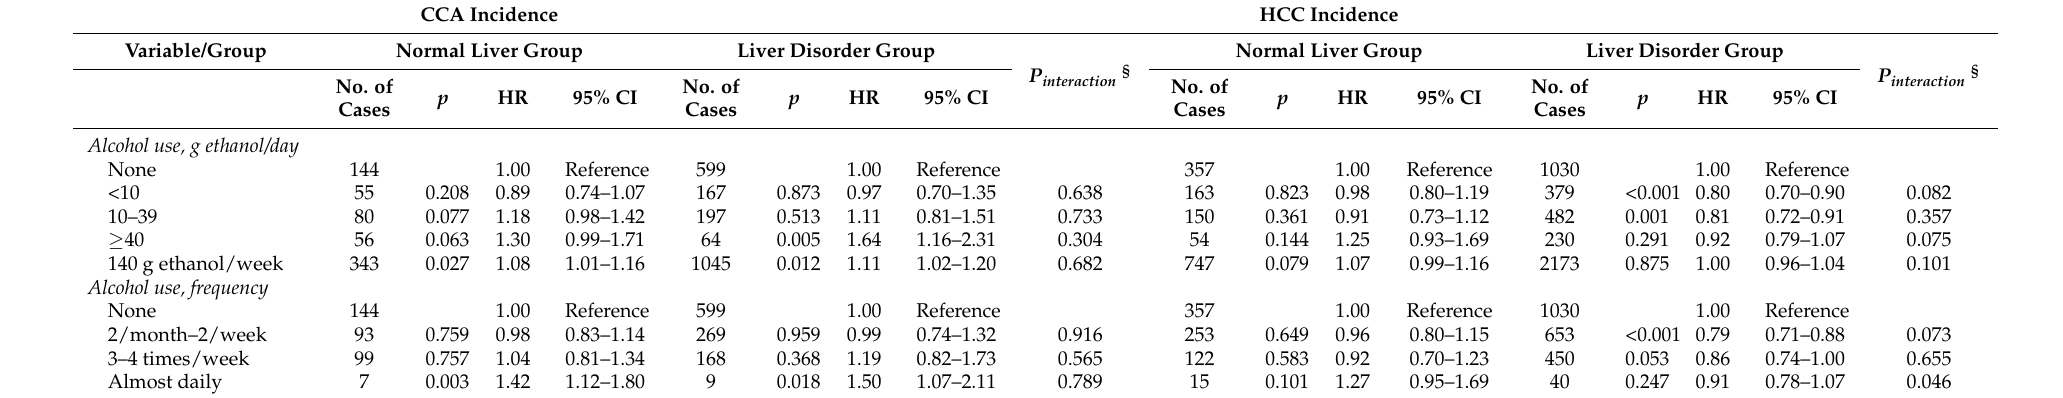
Table 4. HRs for CCA and HCC incidence according to liver disorder